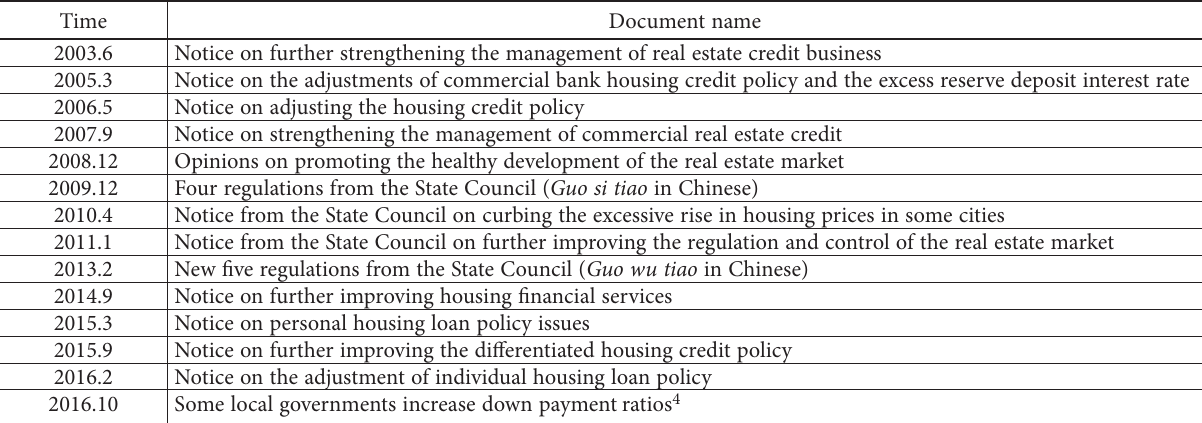
Table 1. Down payment policy documents (data source: The People’s Bank of China and the State Council) Time